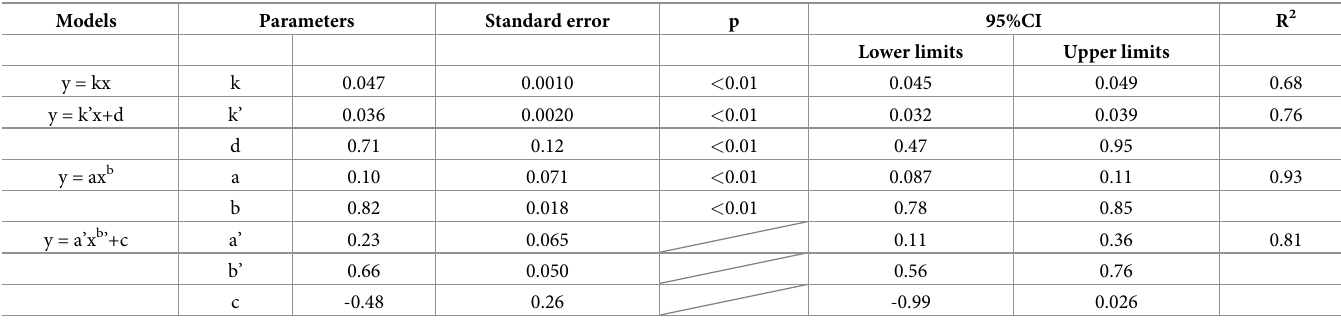
Table 3. Estimated values for different models.